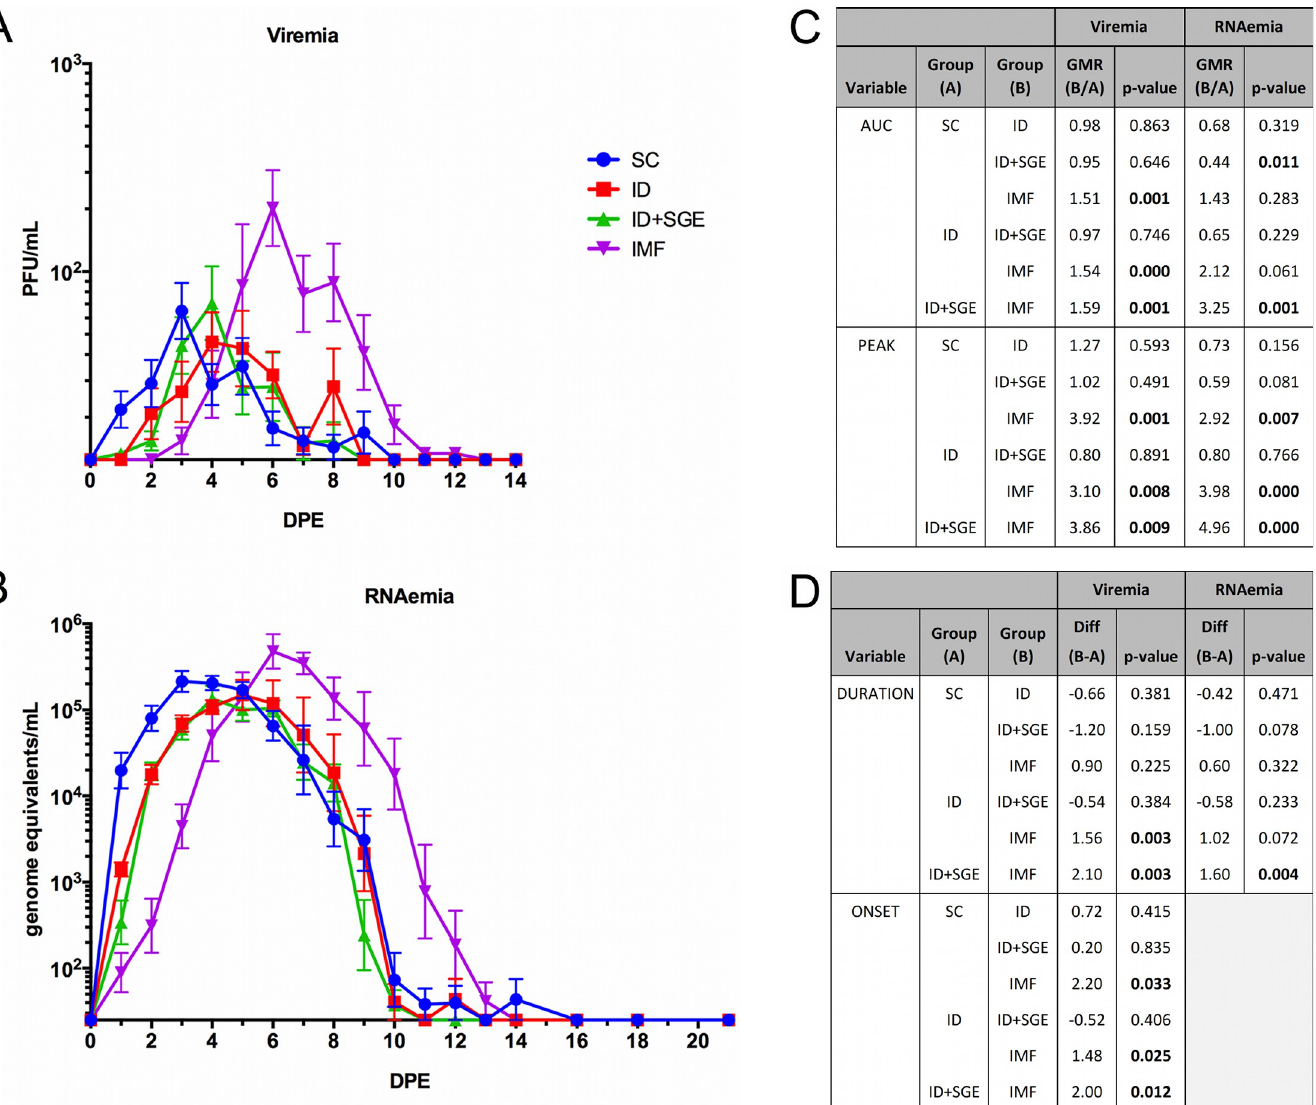
Fig 1. Differential viremia and RNAemia profiles after primary DENV-1 infection via subcutaneous, intradermal (with or without salivary gland extract) or infectious mosquito feeding exposure. Sera were collected daily following DENV-1 exposure and tested, in duplicate, by A) plaque assay for their infectious virus (viremia) titer expressed as plaque forming units (PFU)/mL, and by B) qRT-PCR for their RNAemia titer expressed as genome equivalents (GE)/mL. Geometric mean titers with standard error of the log 10 -transformed mean are displayed. C) Geometric mean ratios (GMR) and p-values for between-group comparisons of viremia and RNAemia areas under the curve (AUC) and peak titers are shown. AUC and peak titers were log 10 -transformed for statistical analysis using an ANOVA model. Peak titers were additionally compared using a non-parametric analysis (ANOVA on ranks) to confirm the log 10 -transformed results. D) Viremia and RNAemia times to onset and durations were compared between groups using an ANOVA model, with Least Squares means differences and p-values shown. n = 10 for each SC, ID+SGE, and IMF. n = 9 for ID. p < 0.05 are in bold text. SC, subcutaneous; ID, intradermal; ID+SGE, intradermal + salivary gland extract; IMF, infectious mosquito feeding; DPE, day post